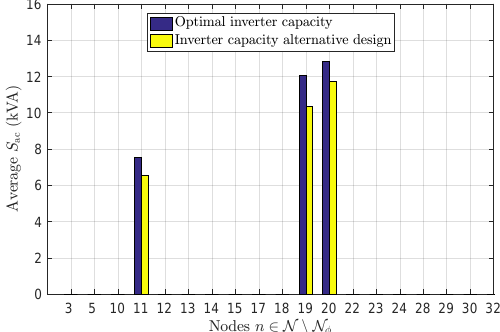
Figure 12. Comparison of average S ac per node.